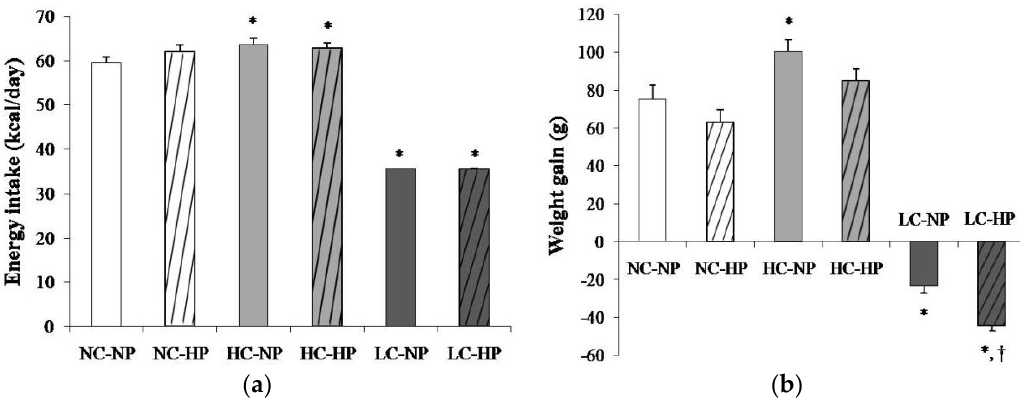
Figure 1. ( a ) Energy intake and ( b ) weight gain after the 7 months that the experiments lasted in rats fed diets with normal calorie-normal phosphorus (NC-NP), normal calorie-high phosphorus (NC-HP), high calorie-normal phosphorus (HC-NP), high calorie-high phosphorus (HC-HP), low calorie-normal phosphorus (LC-NP) and low calorie-high phosphorus (LC-HP). n = 8 rats per group. * p < 0.05 vs. NC-NP, † p < 0.05 vs. LC-NP.